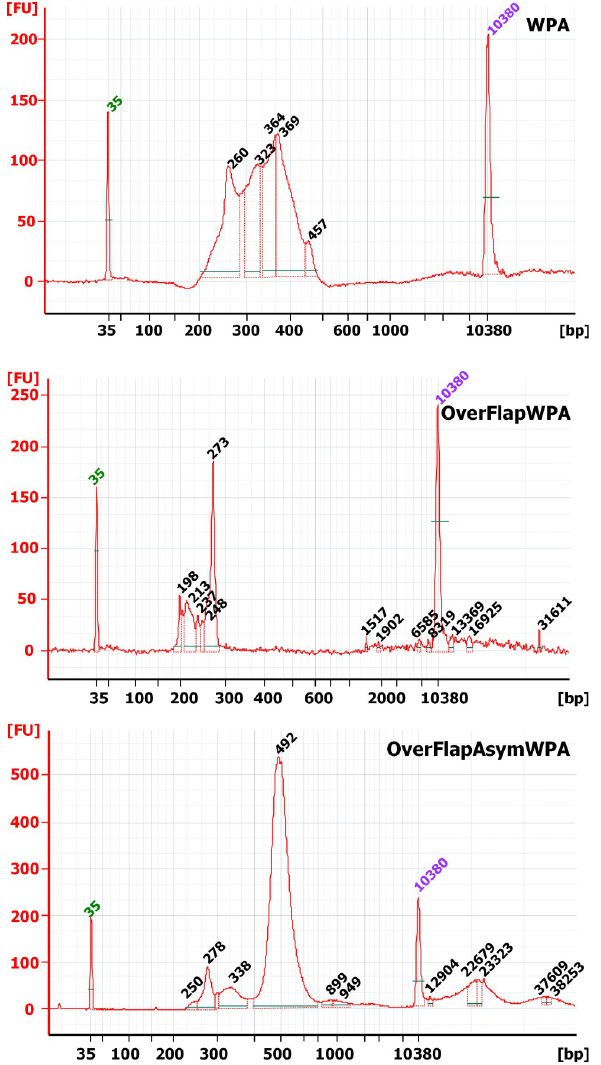
Fig 6. Chromatograms of the sequencing library fragment sizing analysis carried out on an Agilent Bioanalyzer 2100. WPA: whole circular plasmid amplification, OverFlapWPA: OverFlapPCR-based whole plasmid amplification, and OverFlapAsymWPA: OverFlapPCR based asymmetric whole plasmid amplification. The 35 bp (green) and 10 380 bp (purple) peaks represent the upper and lower markers employed by data analysis software for the internal calibration of each